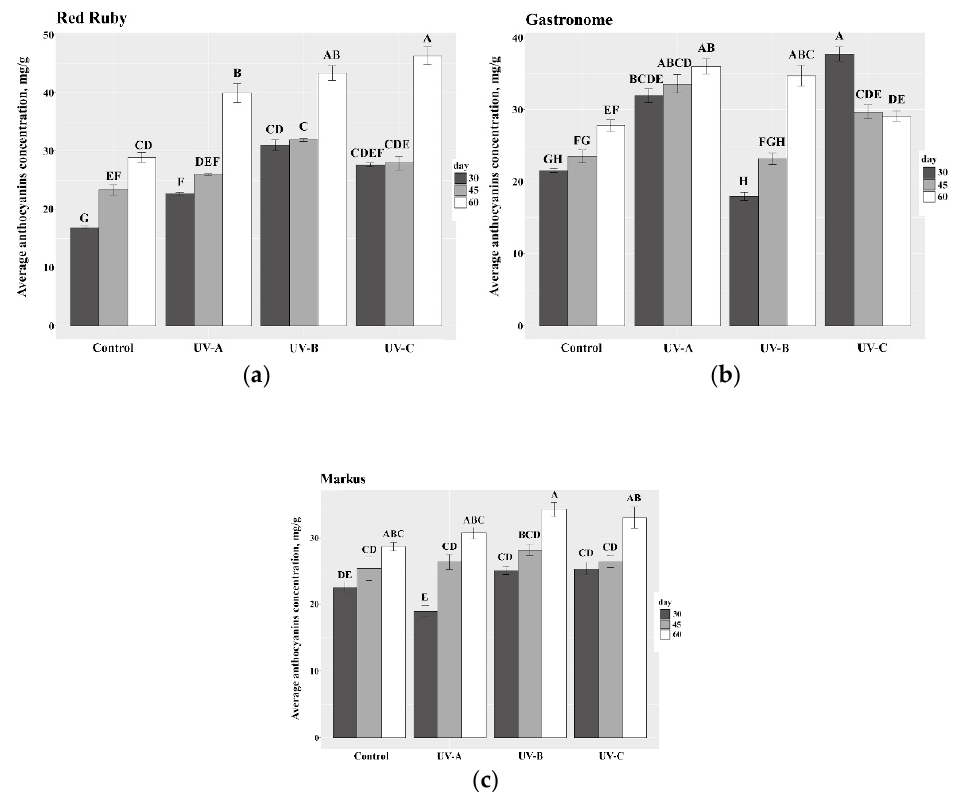
Figure 4. Average anthocyanins concentration on 30th, 45th and 60th day of cultivation of basil “Red Ruby” ( a ), “Gastronome” ( b ) and “Markus” ( c